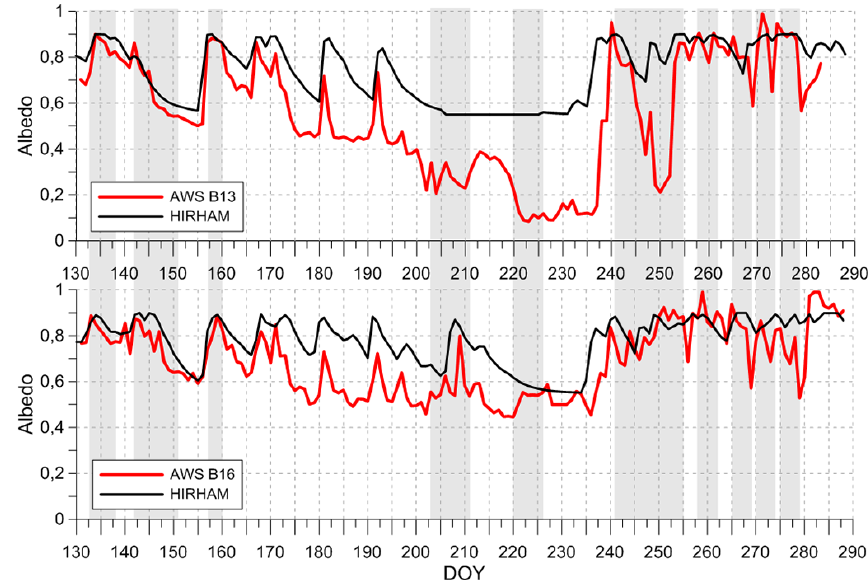
Figure 7. Measured albedo (red line) and albedo simulated with HIRHAM5 (black line) for a clean glacier surface without dust at the stations B13 (upper graph) and B16 (lower graph). Highlighted in grey are modelled dust event periods by